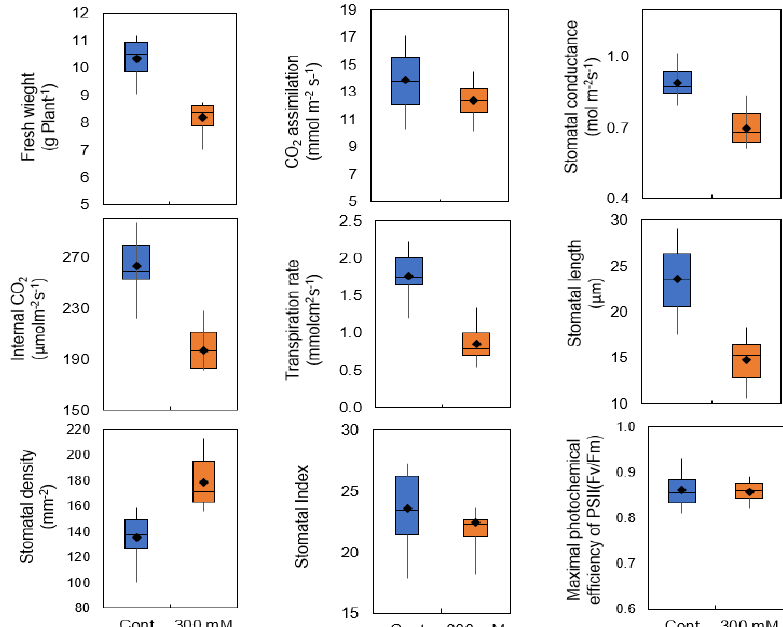
Figure 1. Fresh weight, CO 2 assimilation, stomatal conductance, and stomatal length, density in the sugar beet exposed to 300 mM NaCl for three weeks. Error bars correspond to the SE of at least 5-15 biologically independent measurements.